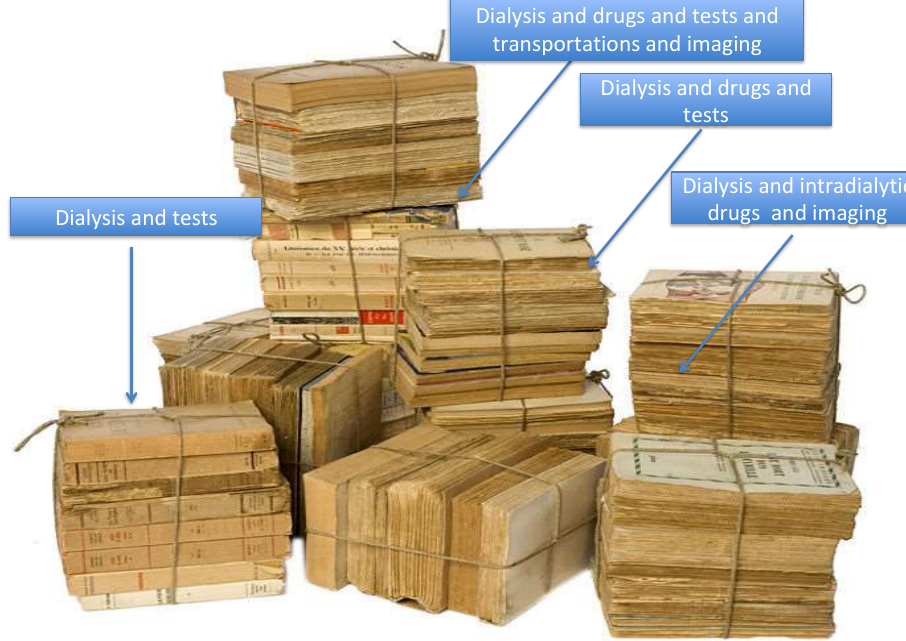
Figure 3. A bundle is not “just a bundle”; its meaning changes according to what is tied together.